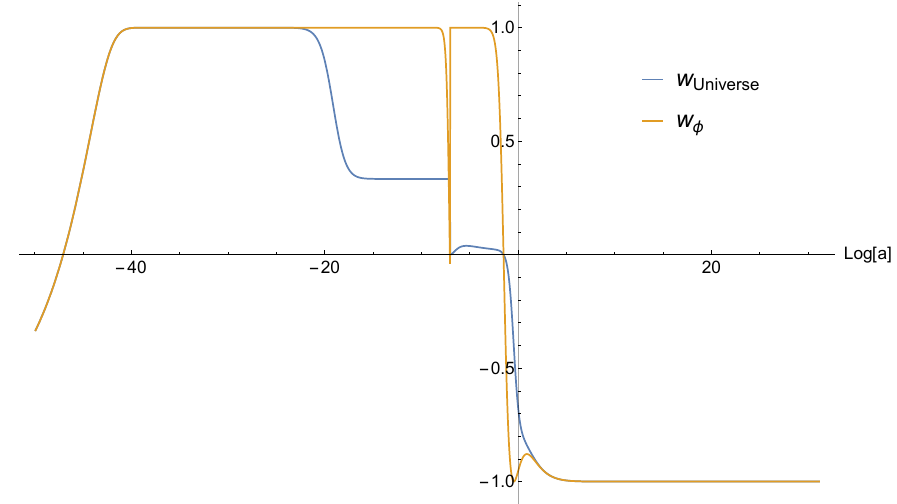
Figure 6. The evolution of the barotropic parameters of the scalar field (orange) and of the Universe (blue) after the end of inflation. We see that during kination both barotropic parameters are the same and equal to unity, because the scalar field dominates. After reheating, the barotropic parameter of the Universe reduces to 1/3, while the scalar field continues to be kinetically dominated with barotropic parameter w φ = 1. The field freezes briefly at radiation–matter equality, when its barotropic parameter is drastically reduced, while the Universe’s barotropic parameter approximates zero. The backreaction due to matter does not allow the scalar field to stay frozen. Instead, it free-falls again with w φ = 1 until the present time, when it reduces drastically towards − 1. The barotropic parameter of the Universe at present is found to be − 0.669.